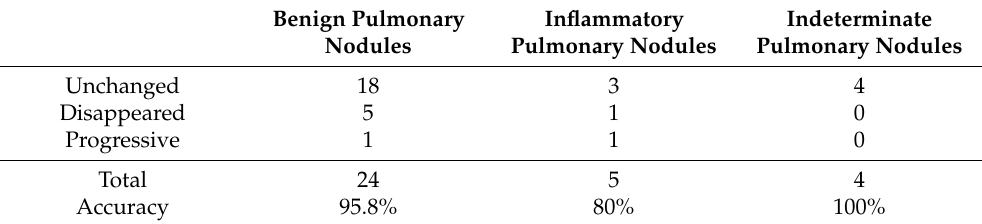
Table 5. Management and outcome of non-metastatic pulmonary nodules.